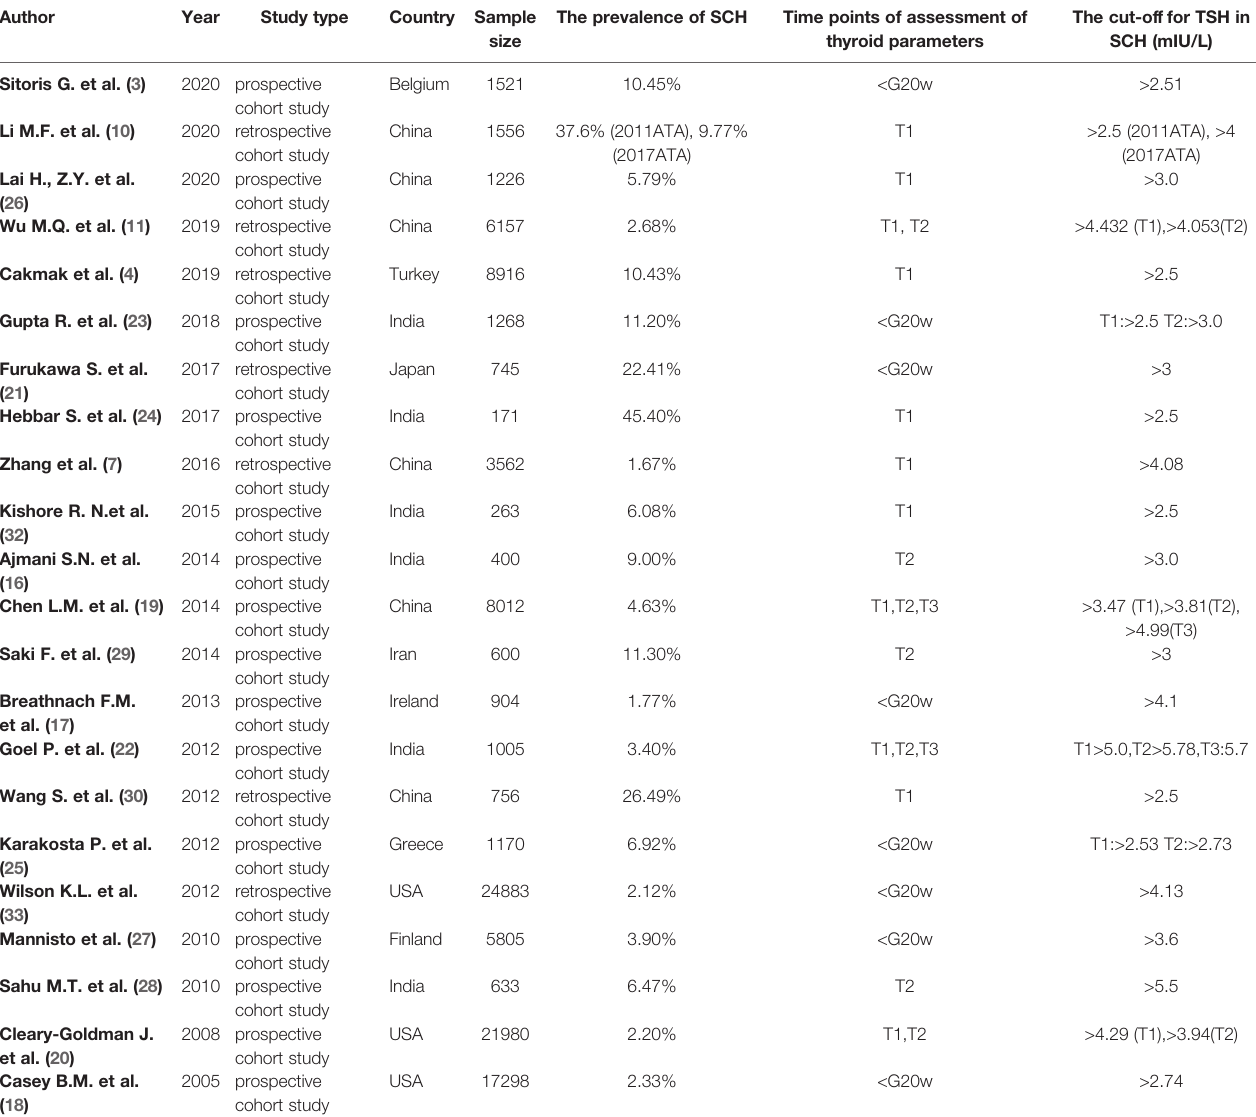
TABLE 1 | The general characteristics of the 22 included